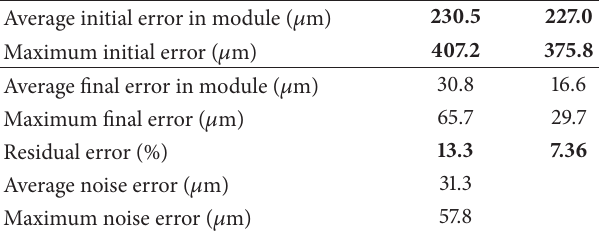
Table9:Rotationalaxischaracterizationwithandwithoutmeasure- ment noise.